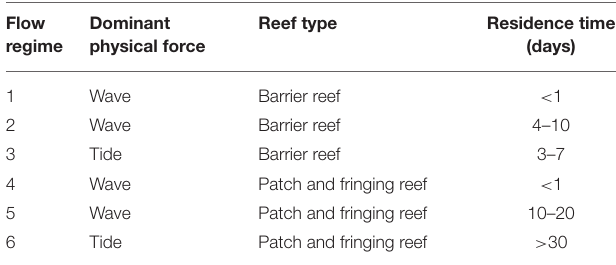
TABLE 1 | Descriptions of residency times and flow regimes in K¯ane‘ohe Bay, Hawai‘i by Lowe et al. (2009). Flow